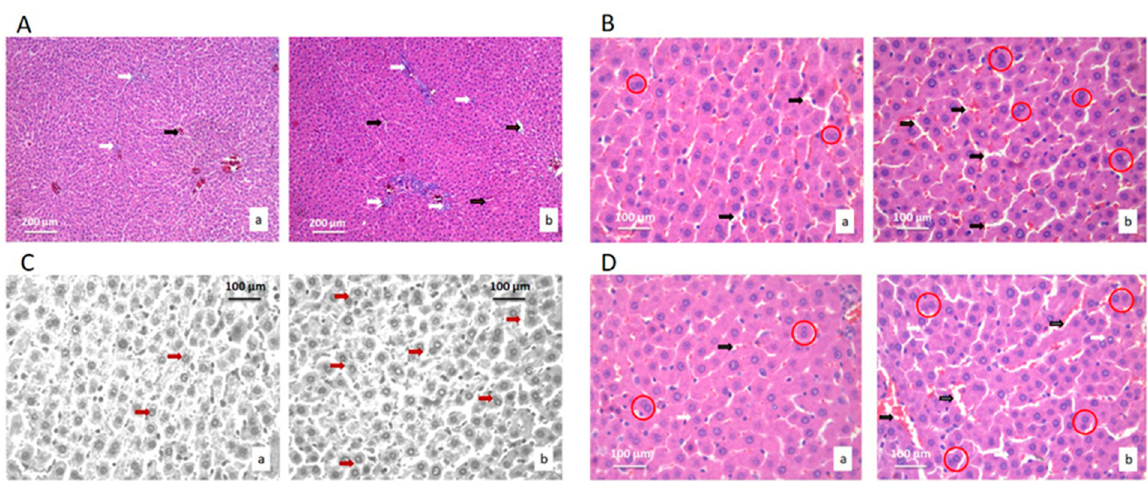
Figure 2. Micrographs of the histological cross-section of the liver of the control group (a) and treated group (b), (H&E). ( A ) White arrows show connective tissue and black show blood vessels. Magnification 20×. ( B ) Black arrows show hepatocytes nuclei, and red circles show hepatocytes with two nuclei. Magnification 50×. ( C ) Red arrows show hepatocytes nuclei. Magnification 50×, digitally processed RGB technique. ( D ) Black arrows show capillary sinusoids, and red circles show hepatocytes with two nuclei. Magnification 50×.